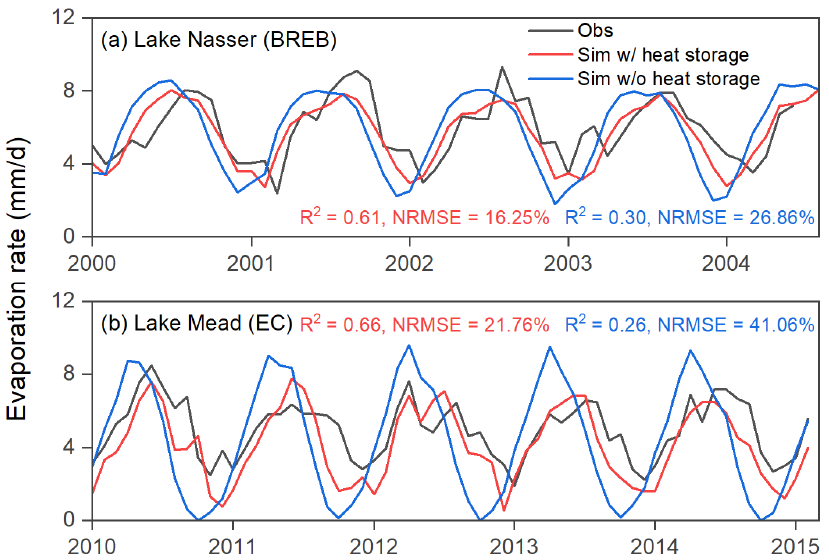
Figure 8. Validation of the evaporation rates for ( a ) Lake Nasser and ( b ) Lake Mead using Bowen ratio energy budget (BREB) estimations and eddy covariance (EC) measurements. The evaporation rate for Lake Mead (from 2010 to 2015) was calculated using MYD21A2 land surface temperature (LST) data because the current version of MOD21A2 only covers the years from 2000 to 2005 (when acquired in November 2020). The evaporation rate for Lake Nasser (from 2000 to 2004) was calculated using MOD21A2 because the MYD21A2 product started from July 2002.